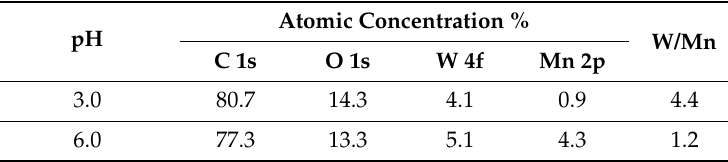
Table 2. Elemental atomic concentrations of the surface modified electrodes determined by